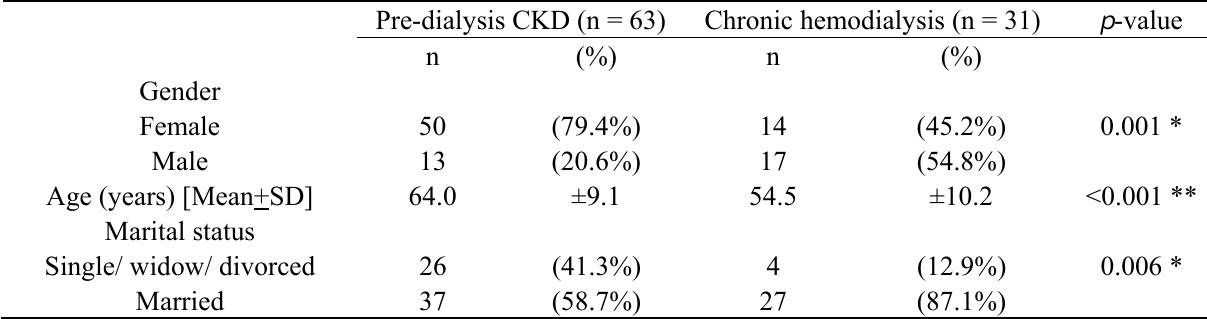
Table 1. Demographic data of pre-dialysis chronic kidney diseases (CKD) and chronic hemodialysis patients (N = 94).